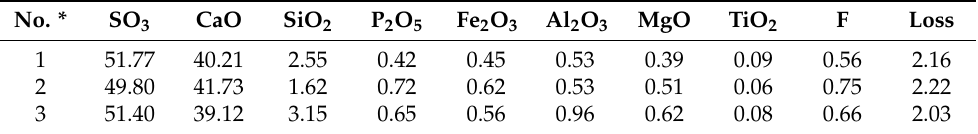
Table 1. The main chemical composition of β -HPG (by weight, wt%).